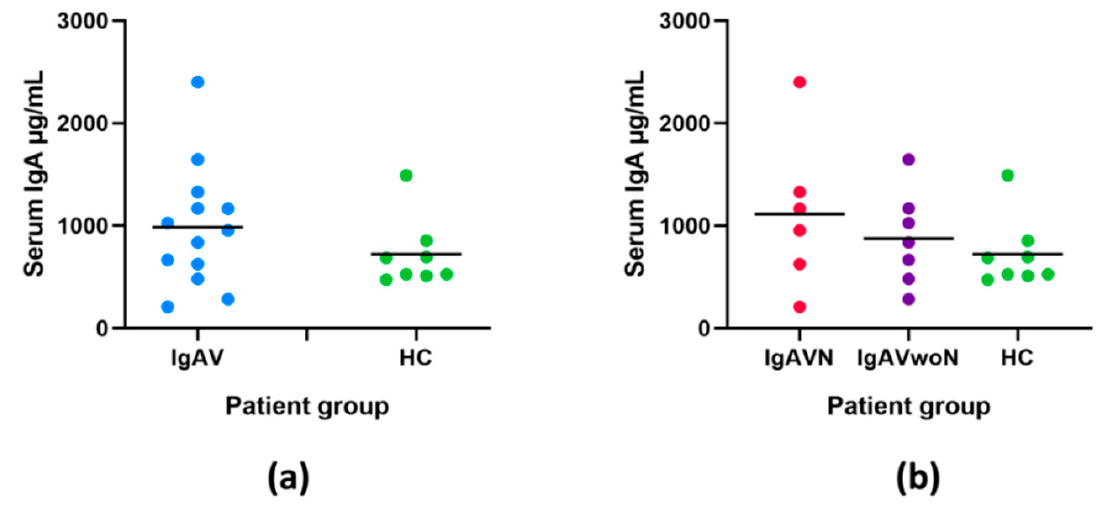
Figure 3. Serum IgA concentrations in patients with IgAV compared to HC ( a ) and in patients with IgAVN, IgAVwoN, and HC ( b ) with mean lines.